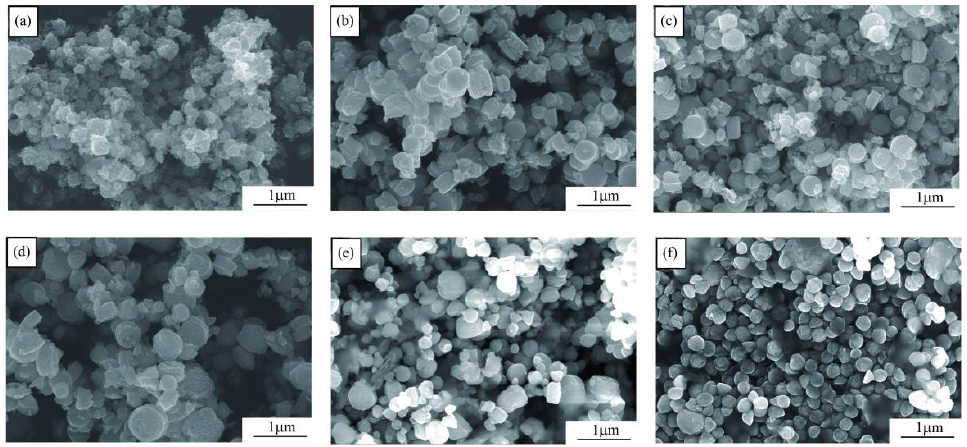
Figure 3. SEM images of pure and doped ZnO nanoparticles. ( a ) Pure ZnO; ( b ) Zn 0.9 Mg 0.1 O; ( c ) Zn 0.6 Mg 0.4 O; ( d ) Zn 0.7 Mg 0.3 O; ( e ) Zn 0.68 Mg 0.3 B 0.02 O; ( f ) Zn 0.66 Mg 0.3 B 0.04